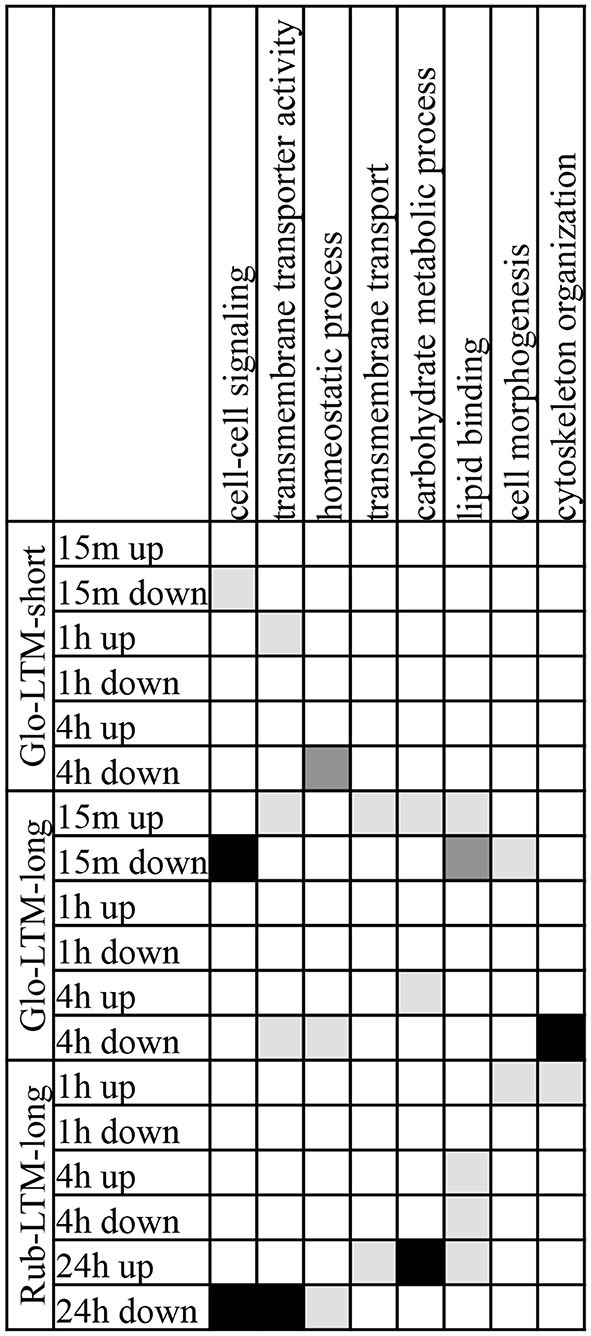
GO terms, each with 10 or more genes, of the categories biological process and molecular function that were enriched in two or three LTM conditioning types in up- and downregulated transcripts at each time point after conditioning. GO terms enriched with P < 0.001 are indicated in black, with 0.01 < P < 0.001 in dark gray, 0.05 < P < 0.01 in light gray.